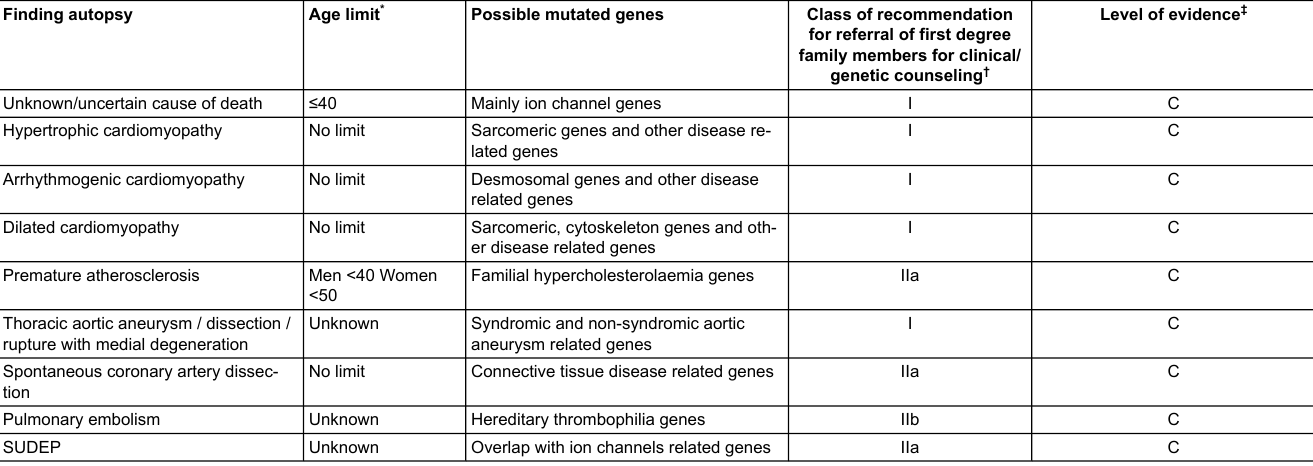
Table 1: Cardiogenetic studies of family members. Class of recommendations based on autopsy findings of the proband. (Adapted from Basso et al. [16]). Finding autopsy Age limit * Possible mutated genes Class of recommendation